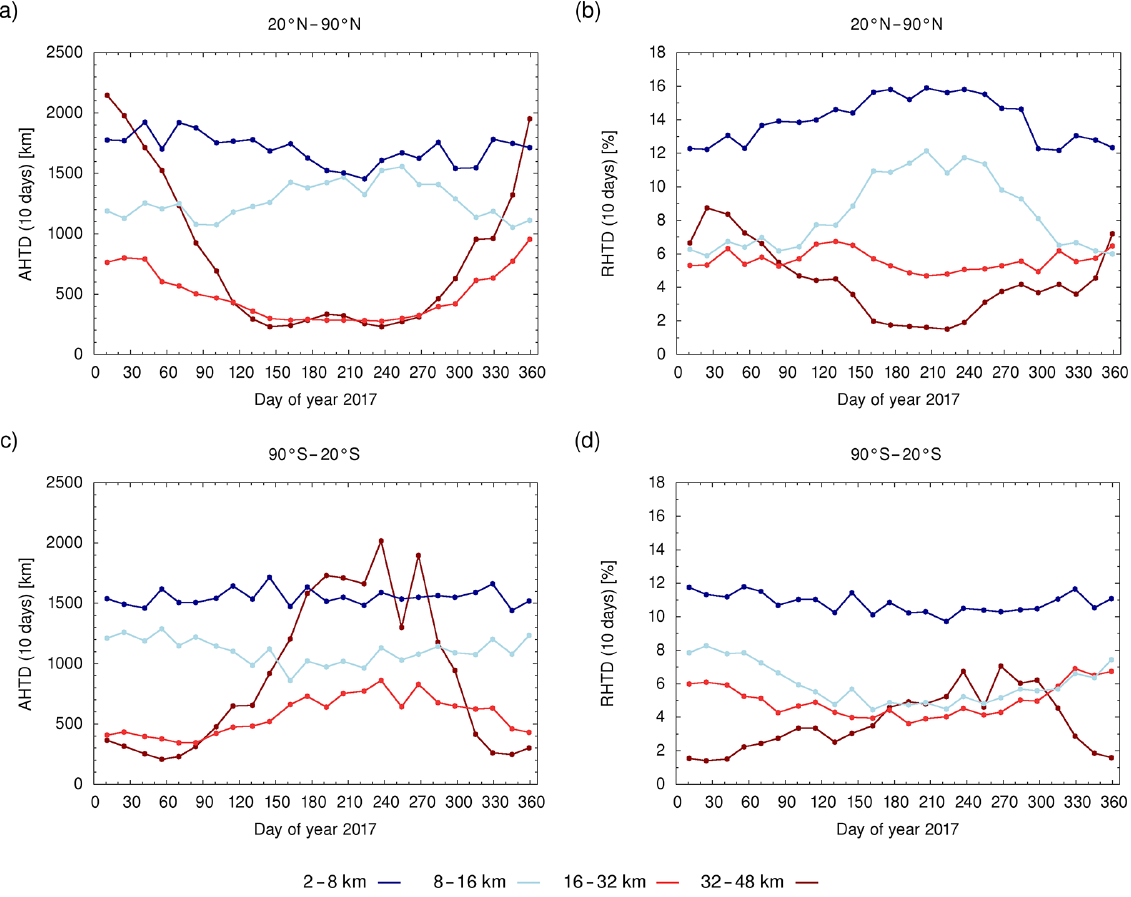
Figure 7. Seasonal variations of absolute (a, c) and relative (b, d) horizontal transport deviations due to parameterized diffusion and subgrid- scale wind fluctuations after 10 days of simulation time for the Northern Hemisphere (a, b) and Southern Hemisphere (c, d) extratropics. Trajectories were calculated with ERA5 data and launched at 00:00UTC on the 1st and 15th of each month in 2017. The color coding refers to different altitude